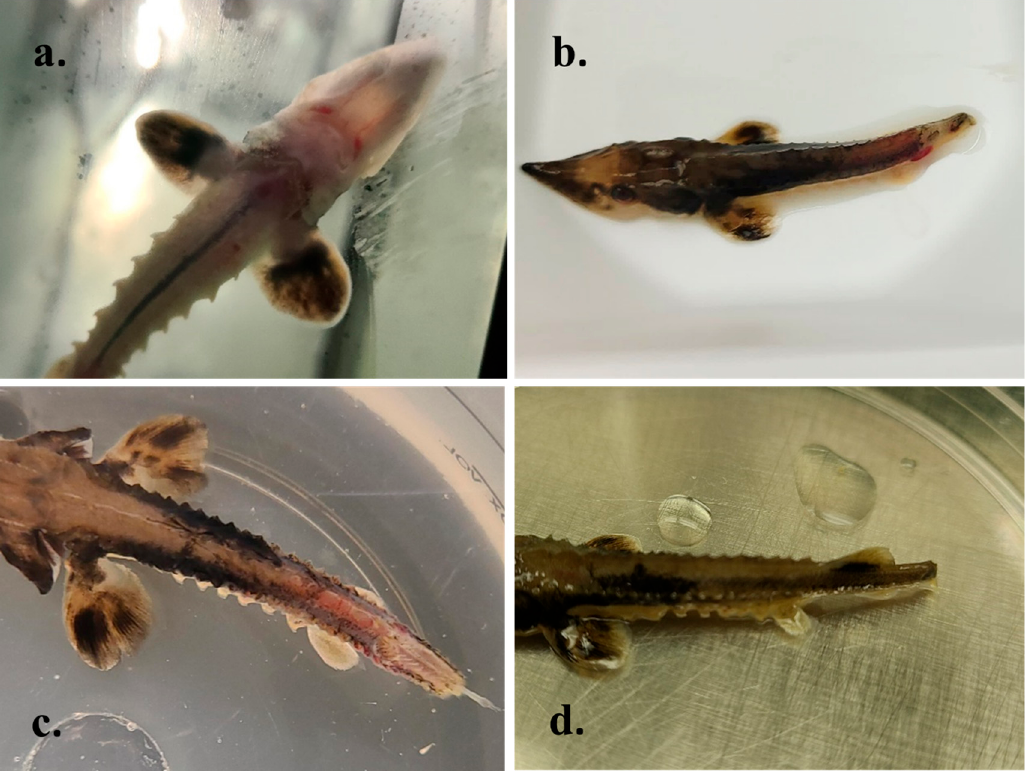
Figure 7. Gross disease signs in juvenile lake sturgeon ( Acipenser fulvescens ) exposed to the newly isolated lake sturgeon herpesvirus (isolate 200413-11TC) via immersion. ( a ) Hemorrhage surrounding the oral siphon extending linearly to the barbels 10 days post-exposure (PE). ( b ) Loss of the caudal fin and ulceration into the caudal peduncle (19 days PE). ( c ) Diffuse hemorrhage on the dorsal aspect of a lake sturgeon, along with deep ulceration of the caudal peduncle, 23 days PE. ( d ) Complete loss of the caudal fin and posterior portions of the caudal peduncle 34 days PE.